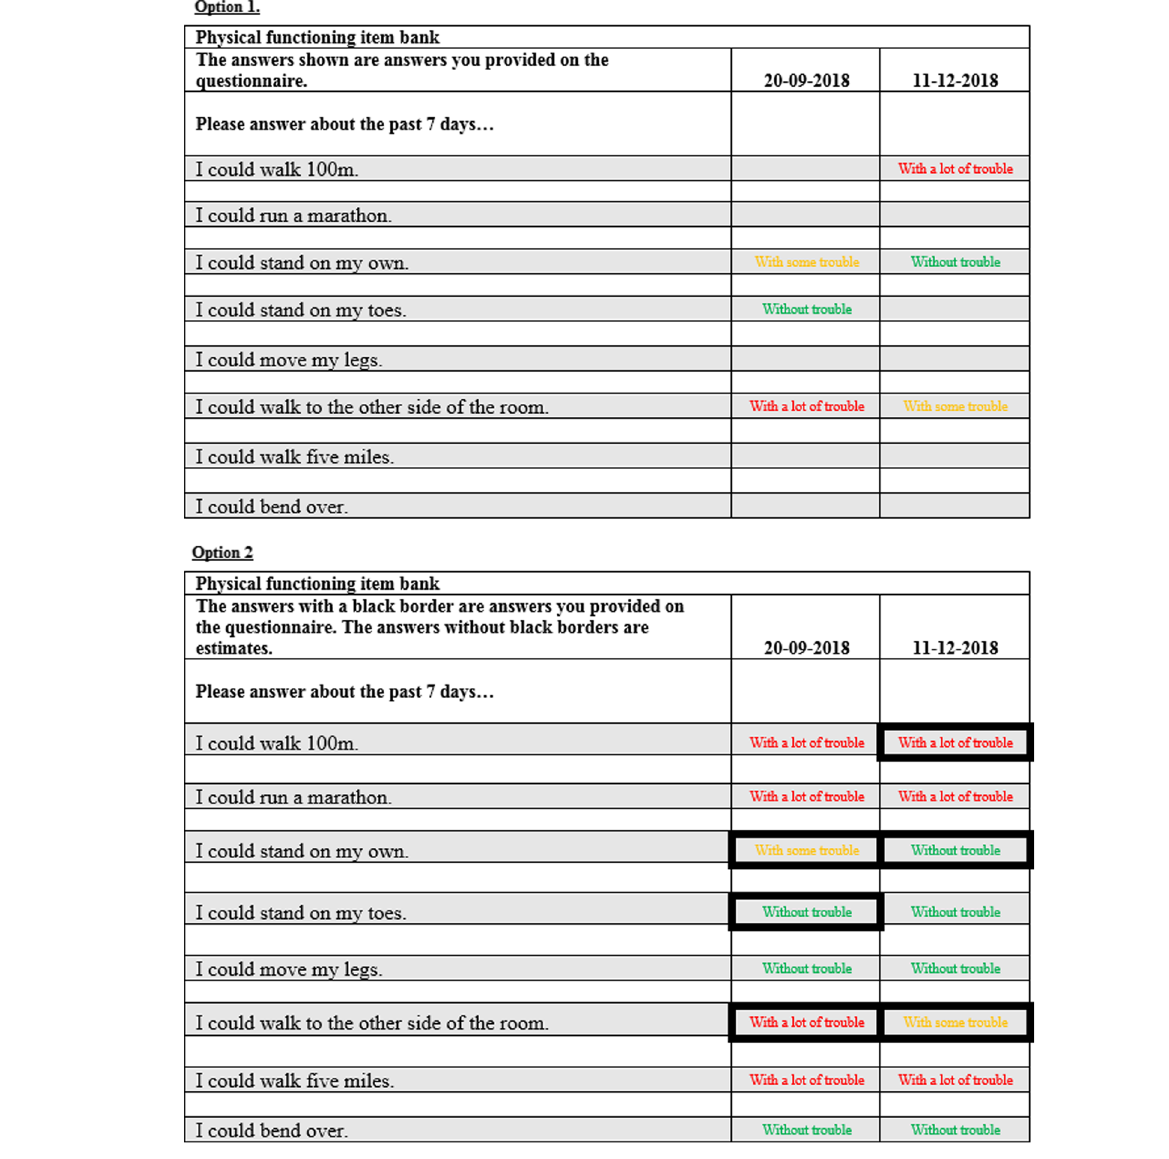
Fig. 3 Two options of individual item feedback shown to patients and parents in